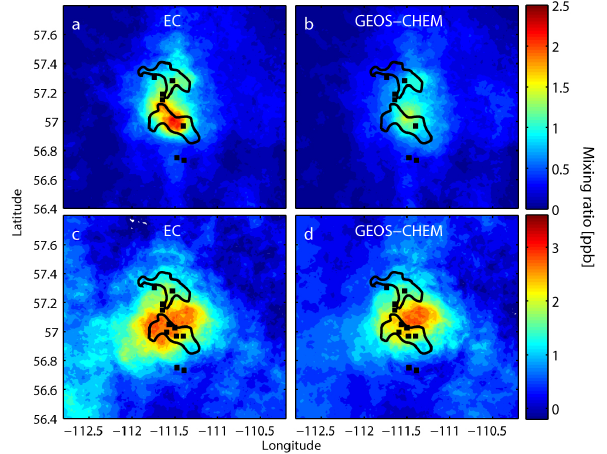
Fig. 10. Average (2005–2011) EC-OMI distributions of NO 2 and SO 2 vmr: (a) EC-OMI NO 2 , (b) the same as (a) but using GEOS- CHEM profiles to calculate AMFs and the column to surface map- ping, (c) EC-OMI SO 2 , and (d) the same as (c) but using GEOS- CHEM profiles to calculate AMFs and the column to surface map- ping. The black squares indicate the location of the NO 2 and SO 2 in situ